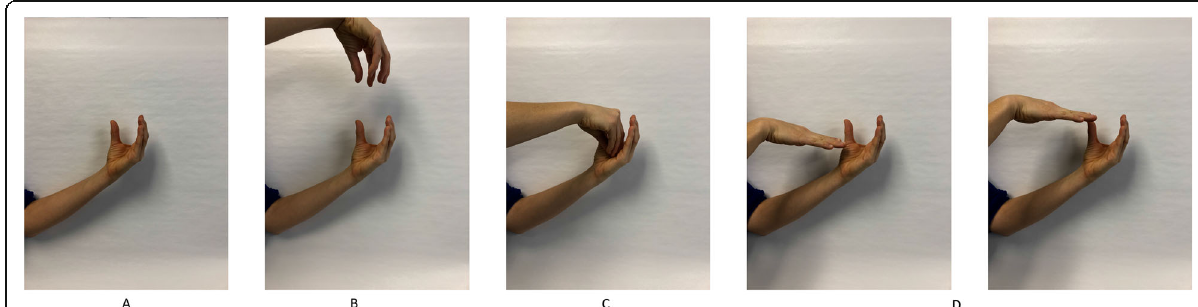
Fig. 3 A temporal sequence illustration of how gesture is used to enhance a teacher's explanation of the function of a rain gauge. Picture a : The hand represents an empty rain gauge with an opening on top. Picture b : The top hand lowers while the fingers move repeatedly back and forth to represent rain falling downward. Picture c : The top hand lowers into the bottom hand to represent the rain falling into the the rain gauge. Picture d : The top hand represents the low water level in the rain gauge when it first begins to rain. Picture e : The top hand moves upward, representing the rising water level in the rain gauge as it continues to rain over